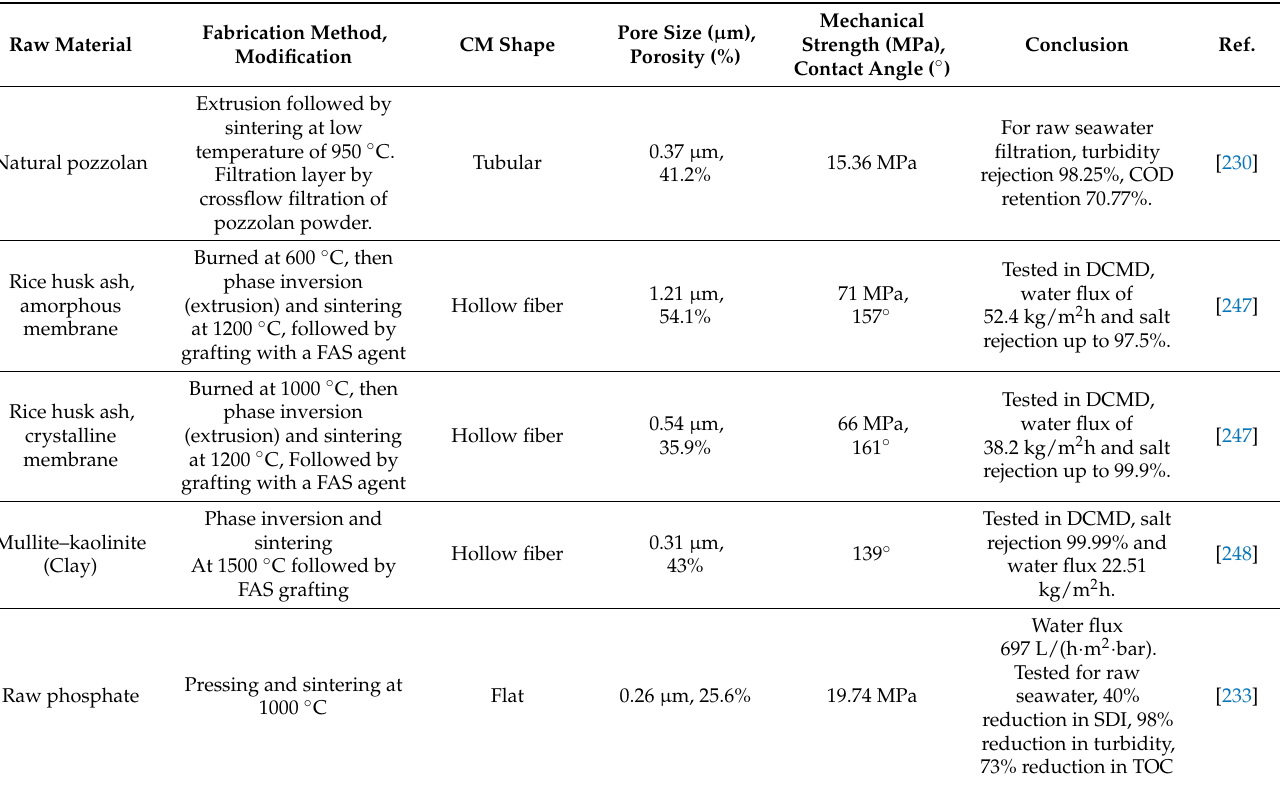
Table 10. Summary of selected studies on water desalination by